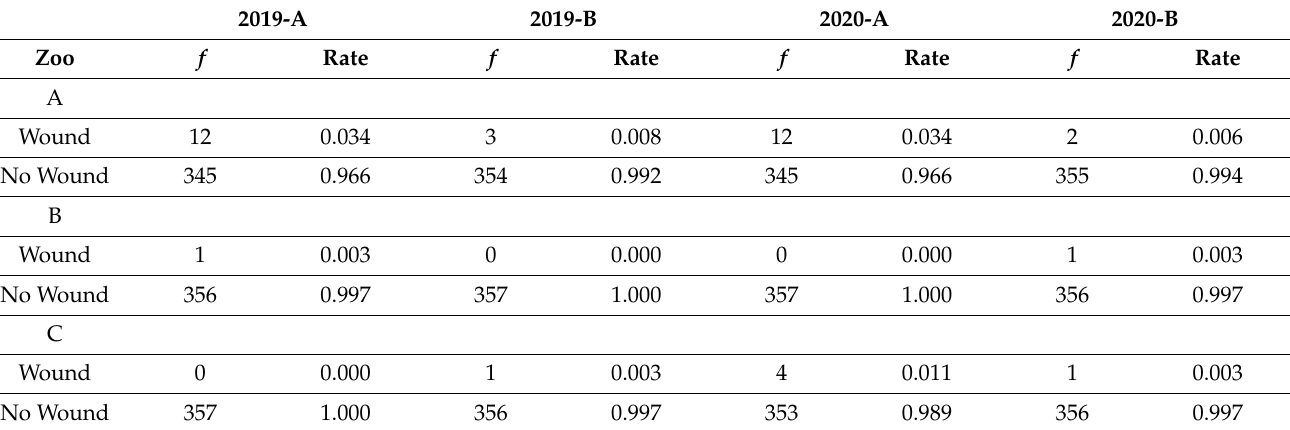
Table 4. Frequency ( f ) of Wound and “No Wound” Events for each Zoo during each Time Condition, and the Corresponding Daily Rates per Chimpanzee.